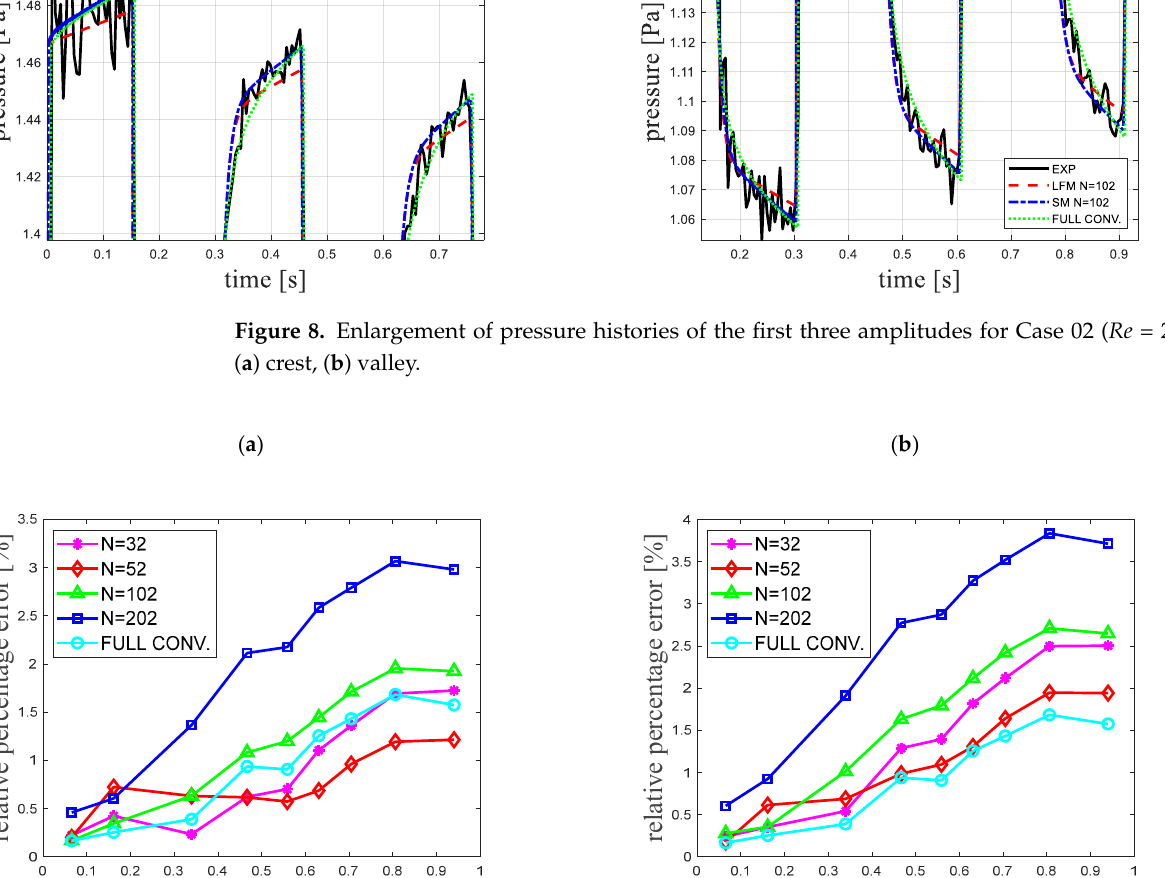
Figure 9. Variation in Ep error coefficient for: ( a ) standard method (SM); ( b ) lumped friction method (LFM). Table 3. Quantitative results of the Et coefficients. Case